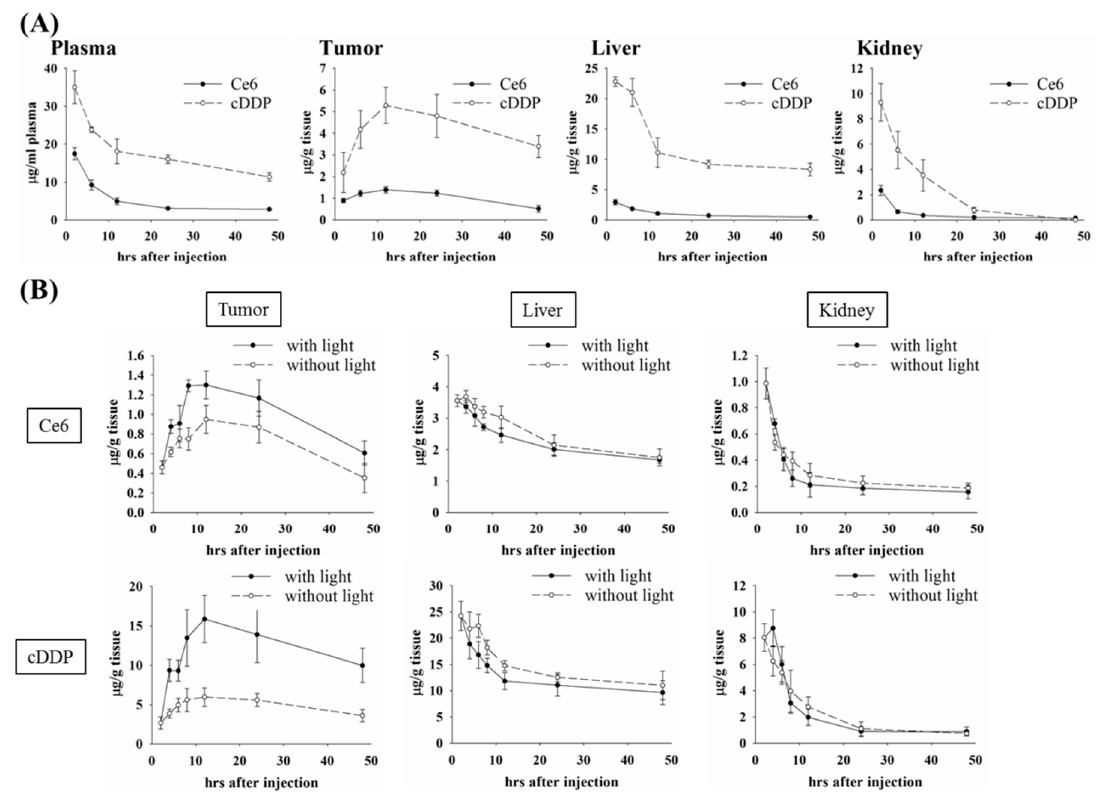
Figure 6. Biodistribution of drugs in C26 tumor-bearing mice after intravenous administration of PL-cDDP-Ce6 (Ce6: 1.75 mg / kg and cDDP: 3.54 mg / kg). ( A ) The concentrations of Ce6 and cDDP in plasma, tumor, liver and kidney at different time points after injection of PL-cDDP-Ce6. Results are expressed as the mean ± S.D. for N = 3 at each time point. ( B ) The concentrations of Ce6 and cDDP in the tumor, liver and kidney of C26 tumor-bearing mice with or without light irradiation at 2 h after drug administration. Results are expressed as the mean ± S.D. for N = 3 at each time point.